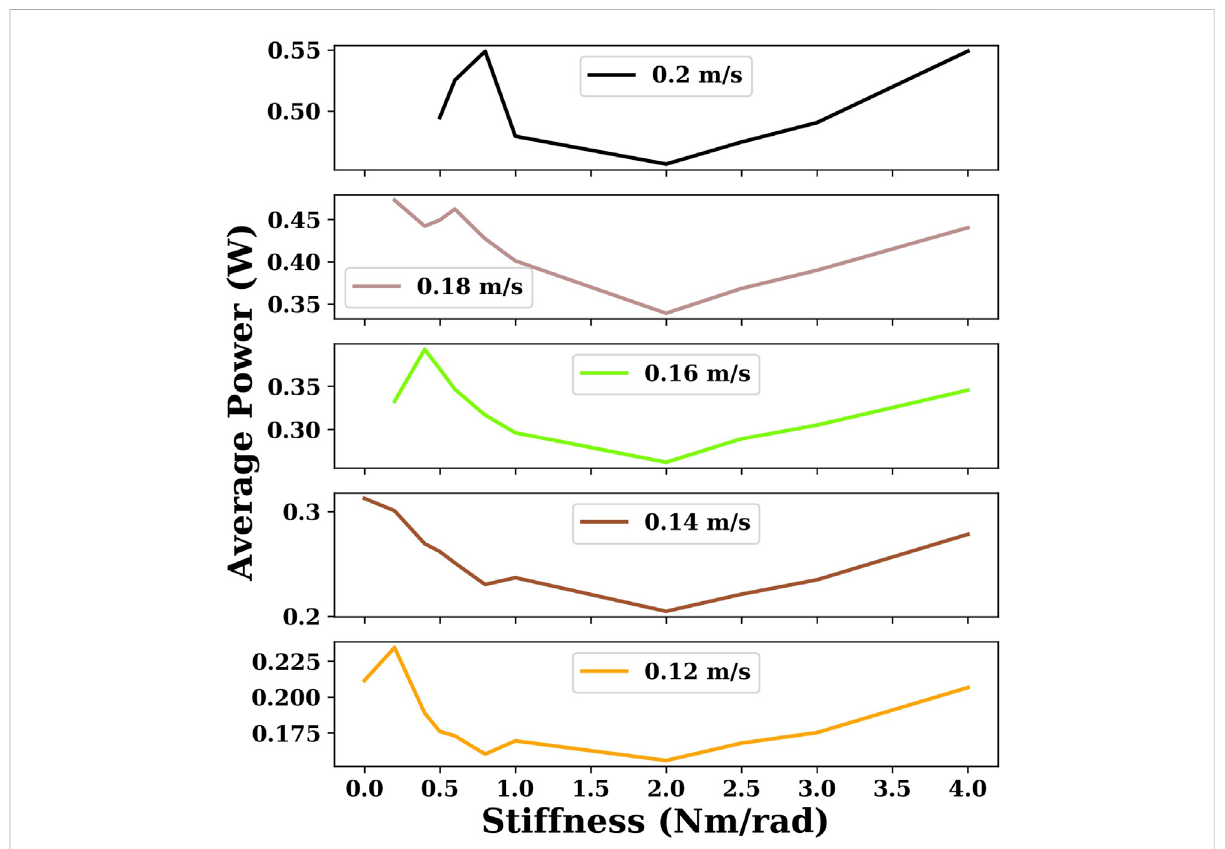
FIGURE 7 This plot indicates the minimum power consumption for the given velocities for snake robots with different joint stiffnesses using the DRL controller. There are some cases of joint stiffness for which there are no sample points when the velocity is large because the maximum velocity of the snake robot is smaller than the given